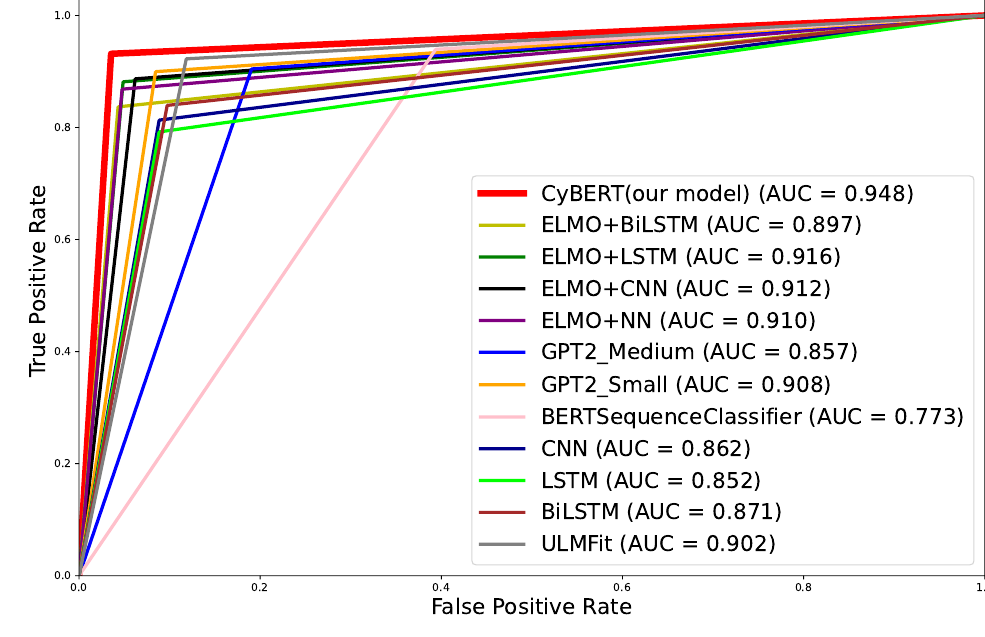
Figure 11. ROC comparison for all